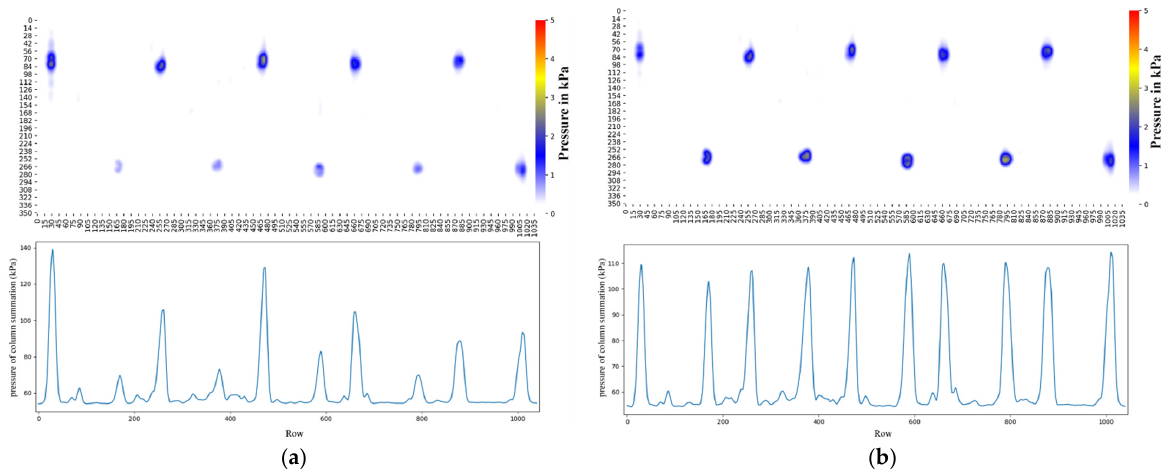
Figure 6. Sensor value with sample weight: ( a ) Before calibration; ( b ) After calibration.